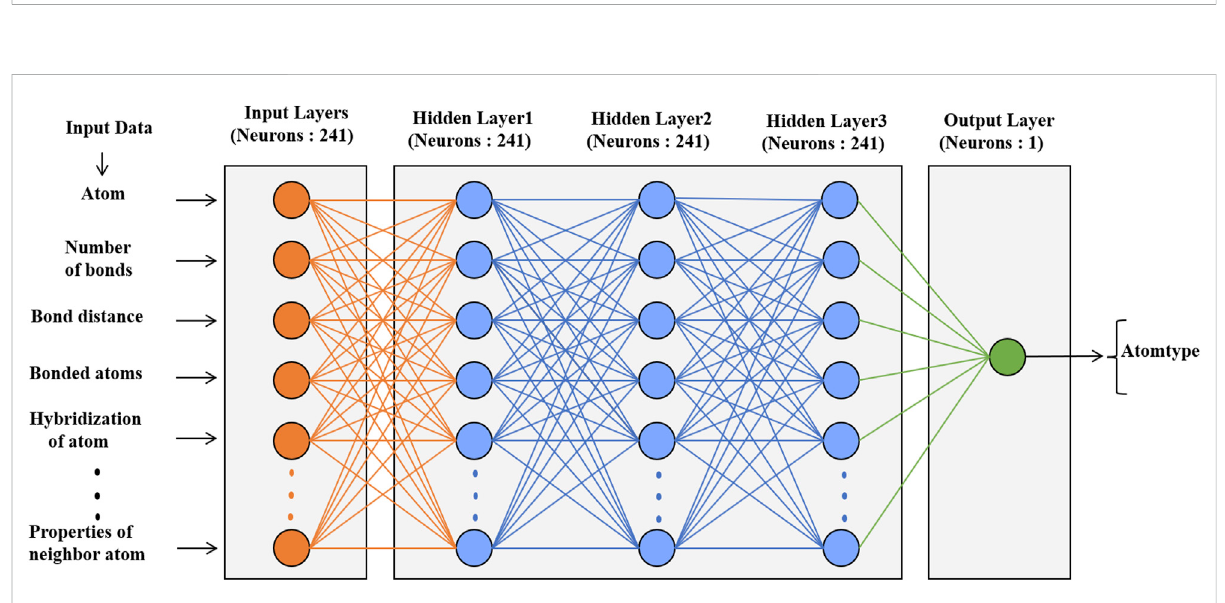
FIGURE 3 Architecture of the neural network model with the numbers of neurons and atomic descriptors for the prediction of atom